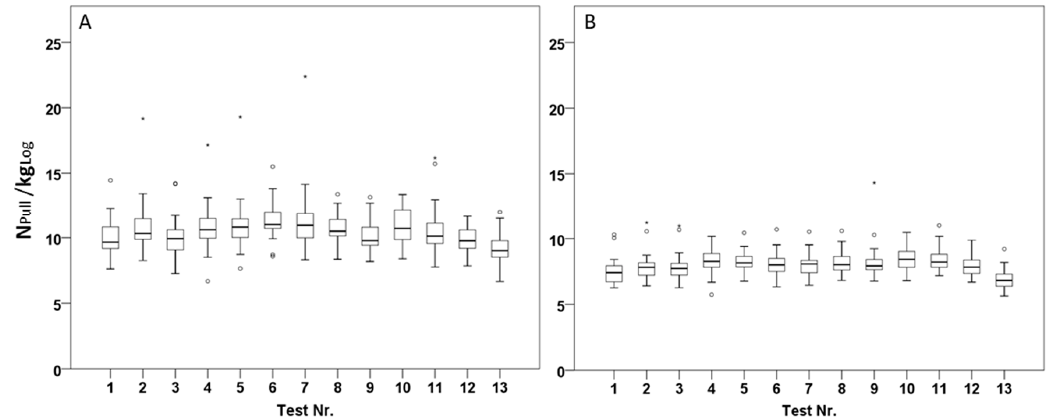
Figure 12. Development of ( A ) static and ( B ) sliding frictions (N Pull / kg Log) within the bark treatment displayed over all test sessions.